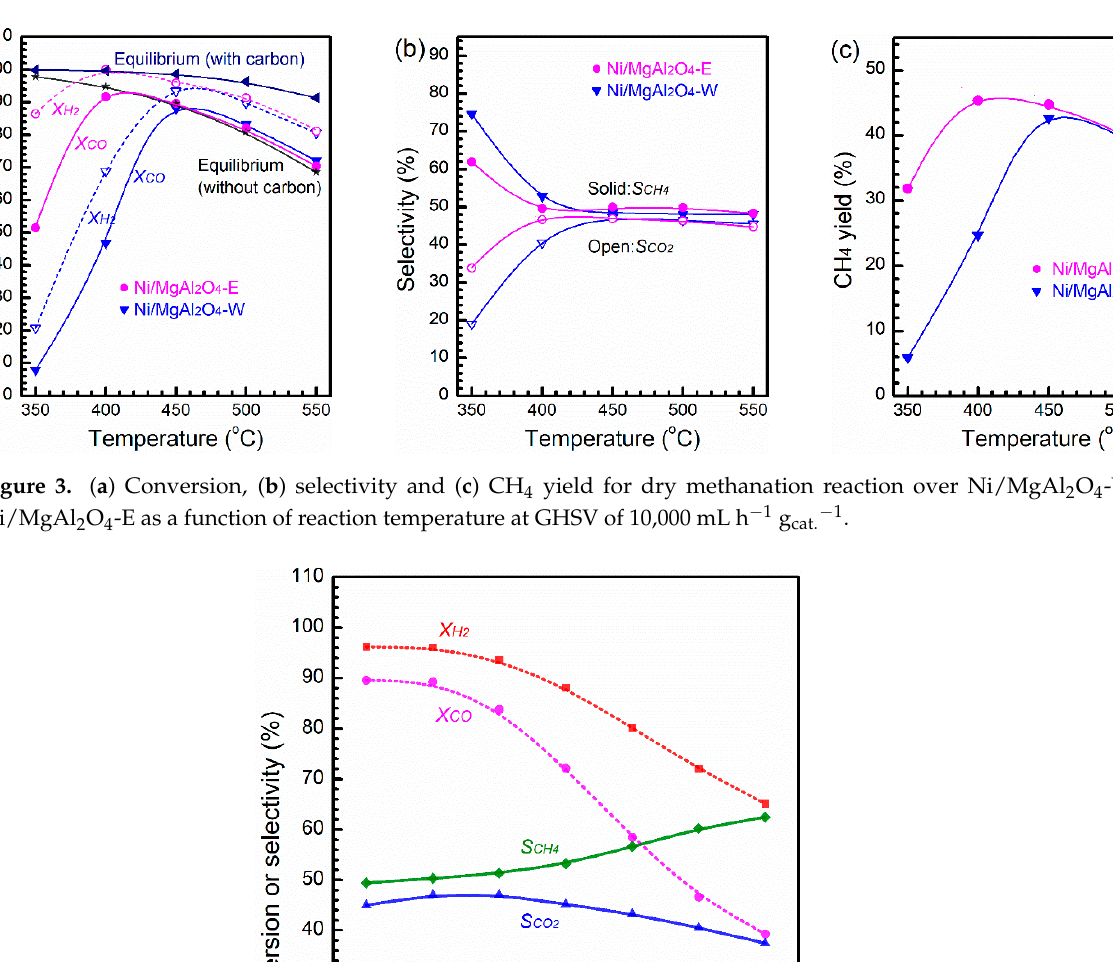
Figure 3. ( a ) Conversion, ( b ) selectivity and ( c ) CH 4 yield for dry methanation reaction over Ni/MgAl 2 O 4 -W and Ni/MgAl 2 O 4 -E as a function of reaction temperature at GHSV of 10,000 mL h − 1 g cat. − 1 .